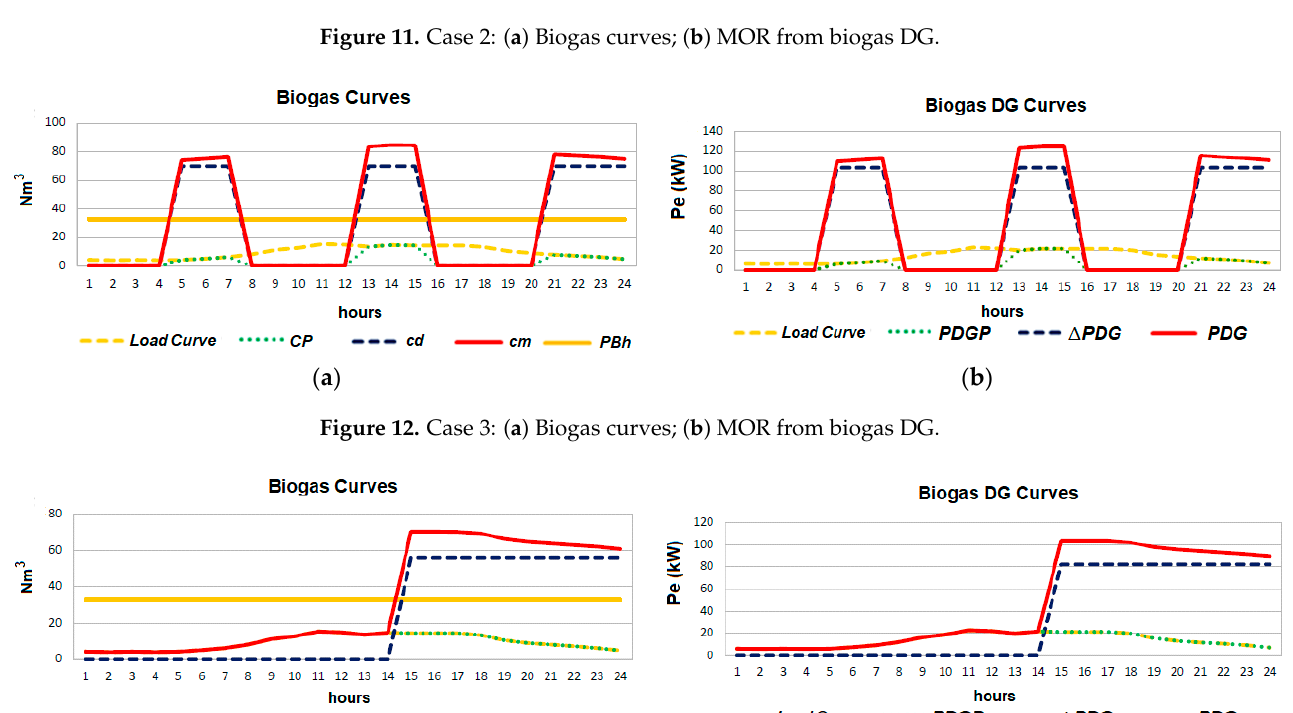
Figure 14. Case 5: ( a ) Biogas curves; ( b ) MOR from biogas DG. ( a ) ( b ) Figure 15. Case 6: ( a ) Biogas curves; ( b ) MOR from biogas DG. ( a ) ( b ) Figure 16. Case 7: ( a ) Biogas curves; ( b ) MOR from biogas DG. The simulation results confirmed the priority of meeting the property load curve on the operating ranges for all cases, while the surplus energy is offered to the distributor for strategic utilization. Electric power generation only occurs on determined ranges for cases 1, 2, 3, and 7. In cases 4, 5, and 6, the DG is used to meet the load curve of the biogas property for 24 h. In case 7, the initial biogas stock is observed to be higher than the min- imum stock, and the simulation results were successfully obtained as well. By observing biogas curves, it is noticed that biogas production is constant along the day, but the PM